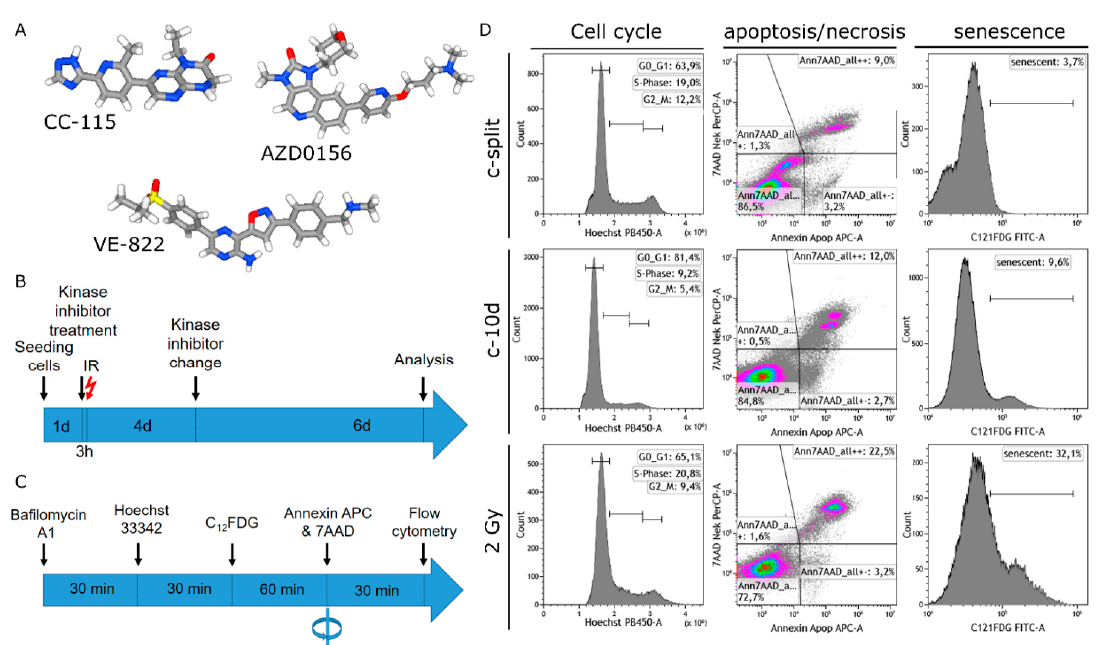
Figure 1. Chemical structures of the used kinase inhibitors, treatment schemes, and gating strategy. Chemical structure of the ( A ) DNA-dependent protein kinase (DNA-PK) and mammalian target of rapamycin (mTOR) inhibitor CC-115, Ataxia telangiectasia mutated kinase (ATM) inhibitor AZD0156 and ataxia telangiectasia and Rad3 related kinase (ATR) inhibitor VE-822. ( B ) Treatment timeline of cell cultures over a period of 11 days. ( C ) The sequence of staining for DNA-content, senescence, apoptosis, and necrosis. ( D ) Gating strategy for cell cycle analysis, apoptosis, and necrosis and senescence in regularly split cultures (c-split), cells seeded for 11 days (c-10d), and cells growing for 10 days after irradiation by 2